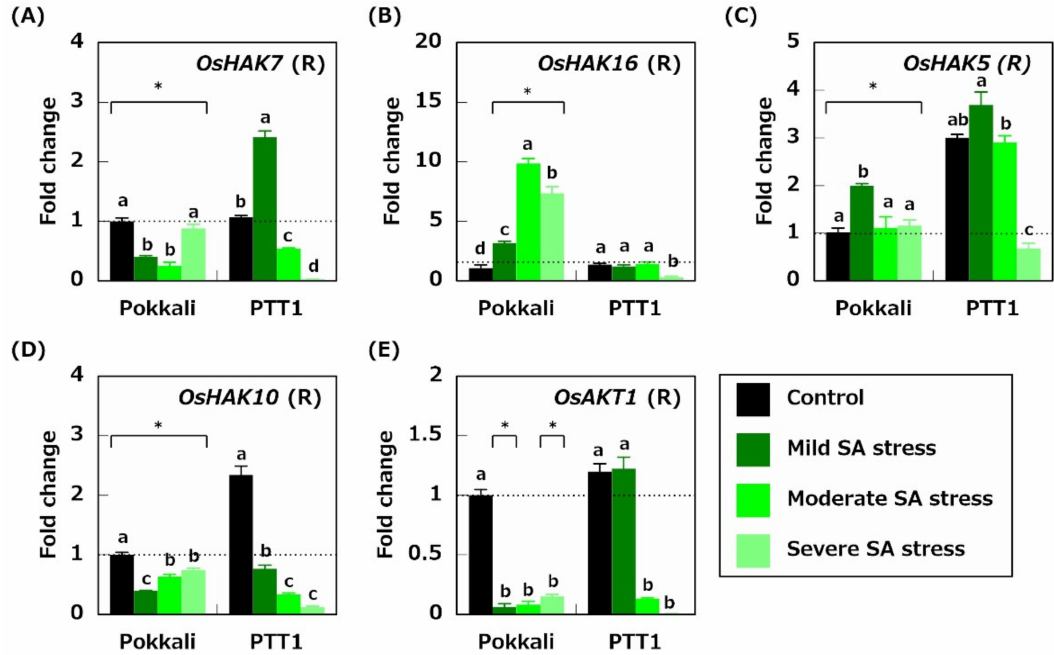
Figure 5. Relative expression of genes encoding K transporters OsHAK7 ( A ), OsHAK15 ( B ), OsHAK5 ( C ), OsHAK10 ( D ), and OsAKT1 ( E ) in the roots of Pokkali and PTT1. The number of gene transcripts is evaluated based on that of Pokkali under control conditions. Similar letters indicate no significant differences between the treatments in each variety ( p < 0.05). Asterisks show significant differences between Pokkali and PTT1 in each treatment ( p <